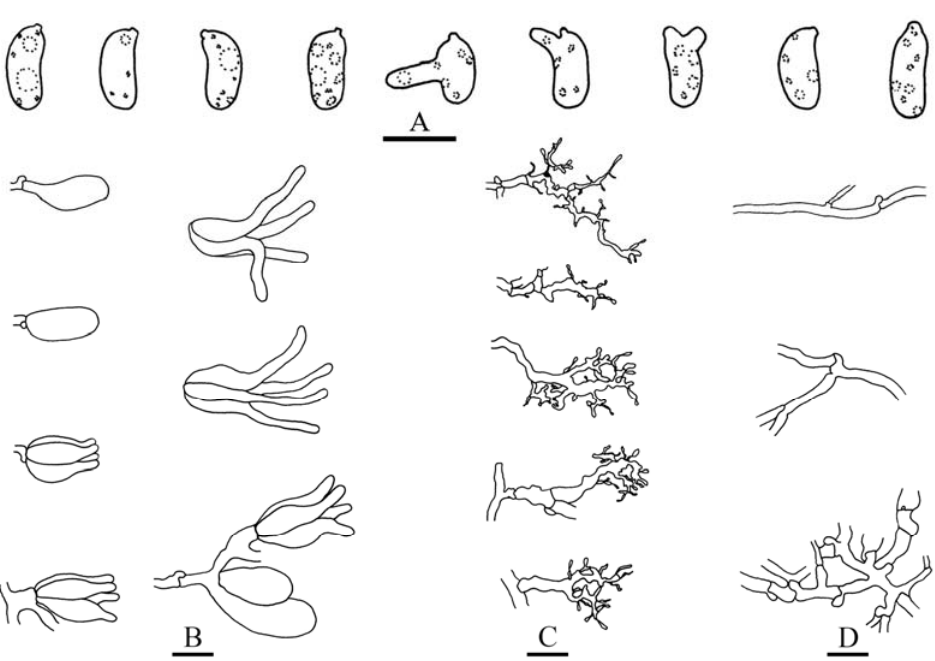
Figure 7. Heterocorticium bambusicola (from the holotype, He 4236, BJFC 023678). Scale bars: ( A–D ) = 10 µ m. ( A ). Basidiospores; ( B ). Basidia; ( C ). Dikaryophyses; ( D ). Generative hyphae.